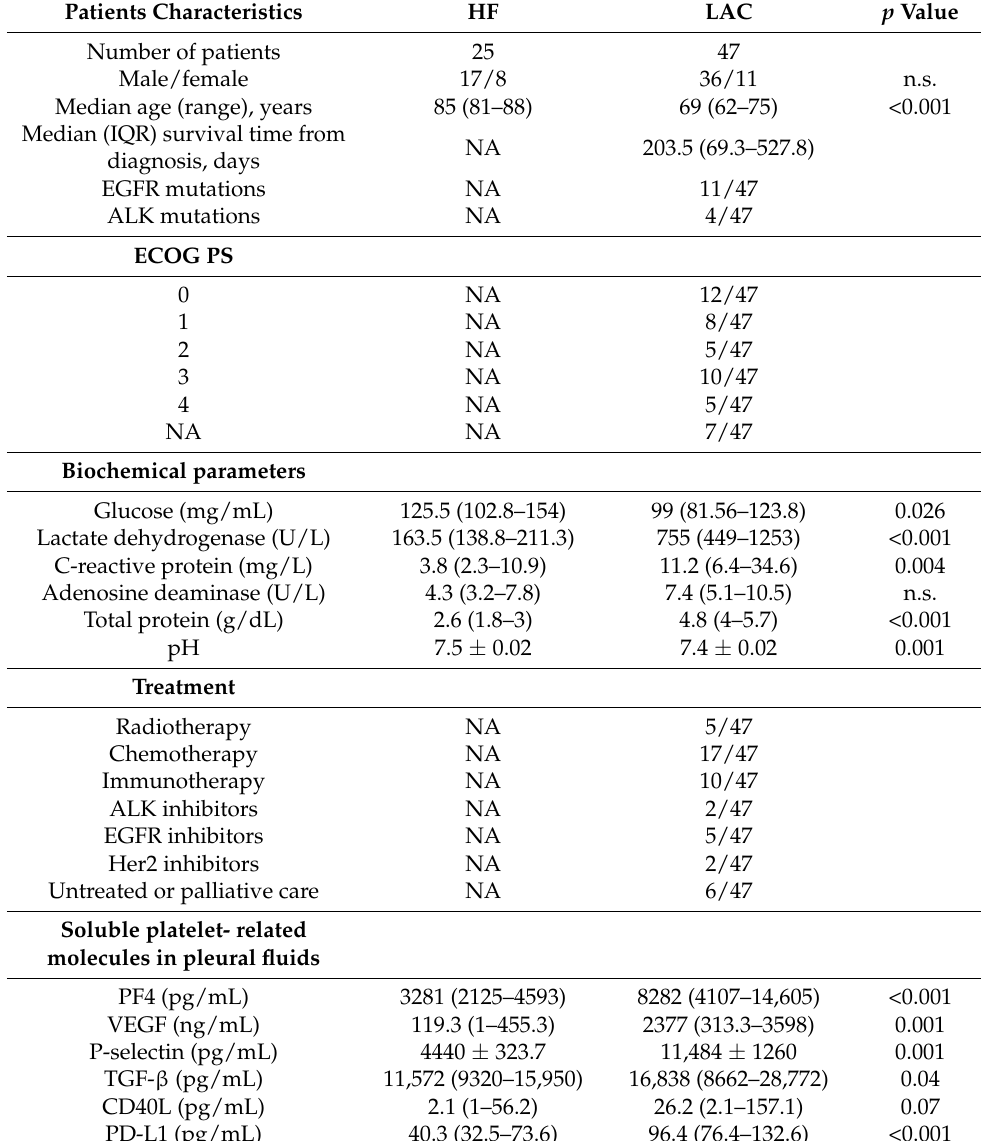
Table 1. Demographic, clinical, and molecular parameters of the patients with pleural effusions included in the